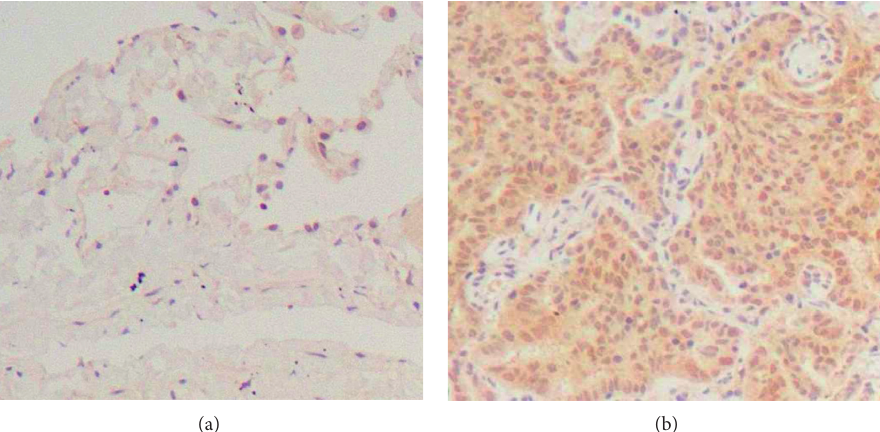
Figure 1: The expressions of LASP1 in human nonmalignant adjacent tissues and lung adenocarcinoma tissues were detected by im- munohistochemical staining (magnification, × 400). (a) Adjacent. (b) Adenocarcinoma.